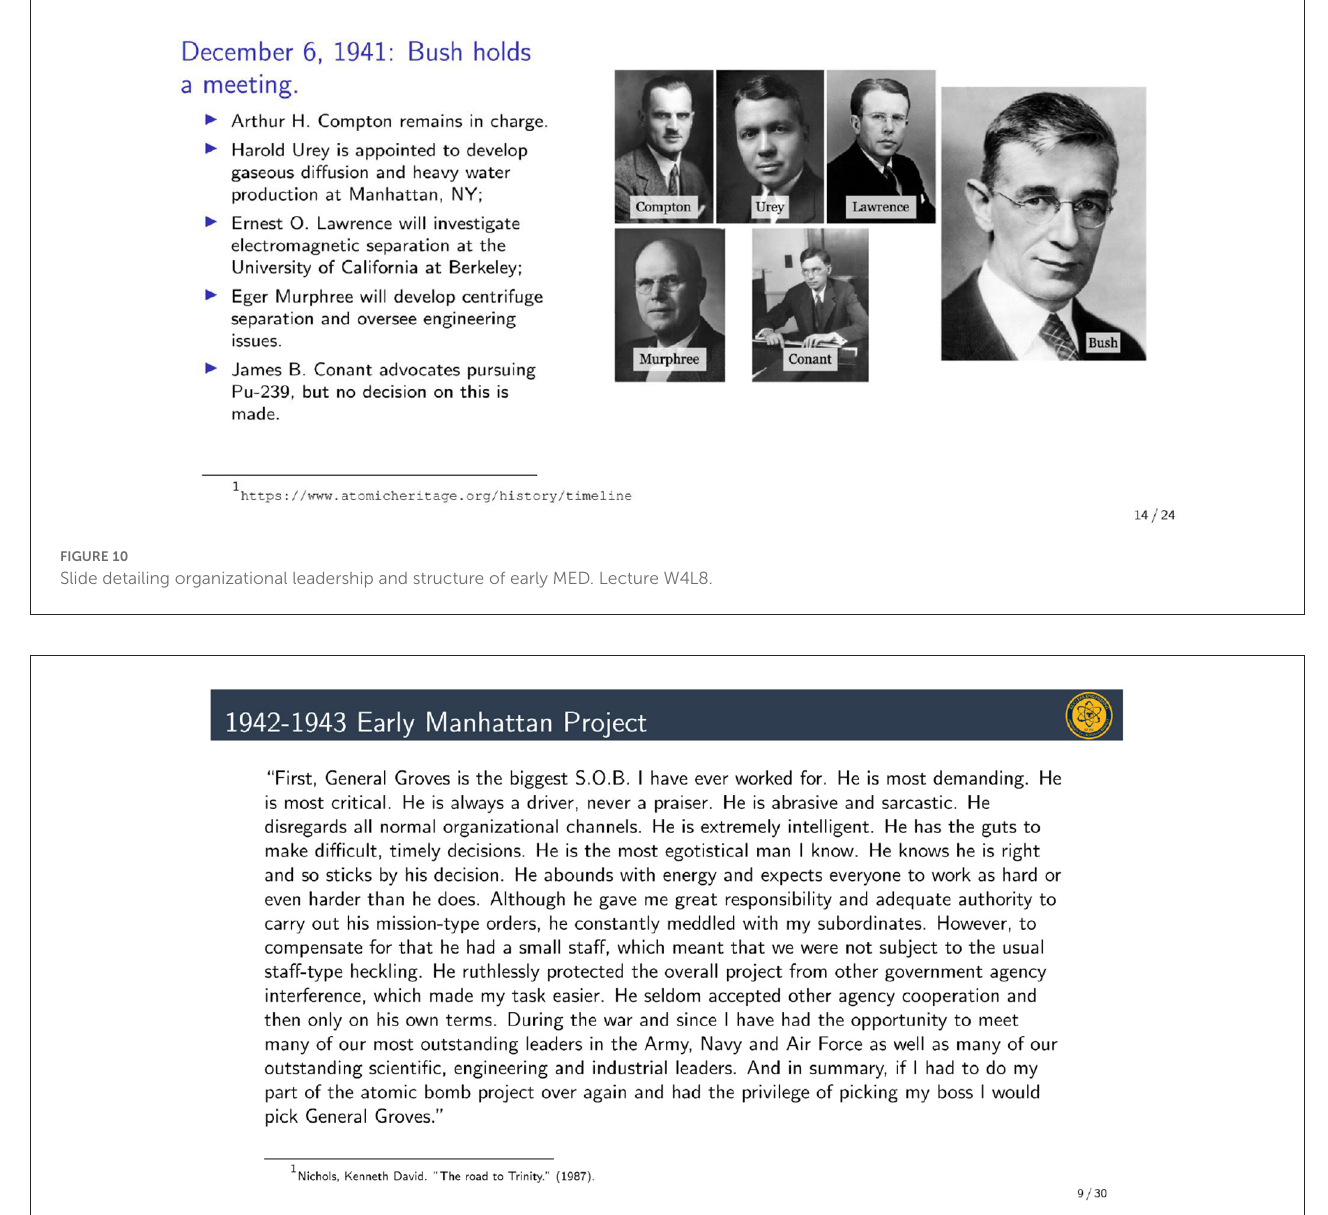
FIGURE11 Nichols on Groves. Lecture